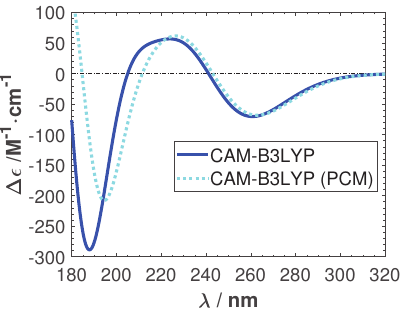
Figure A1. The average ECD spectra of ten sampled structures with CAM-B3LYP in the gas phase and in a polarizable continuum model (PCM) water environment. No calculated spectra were